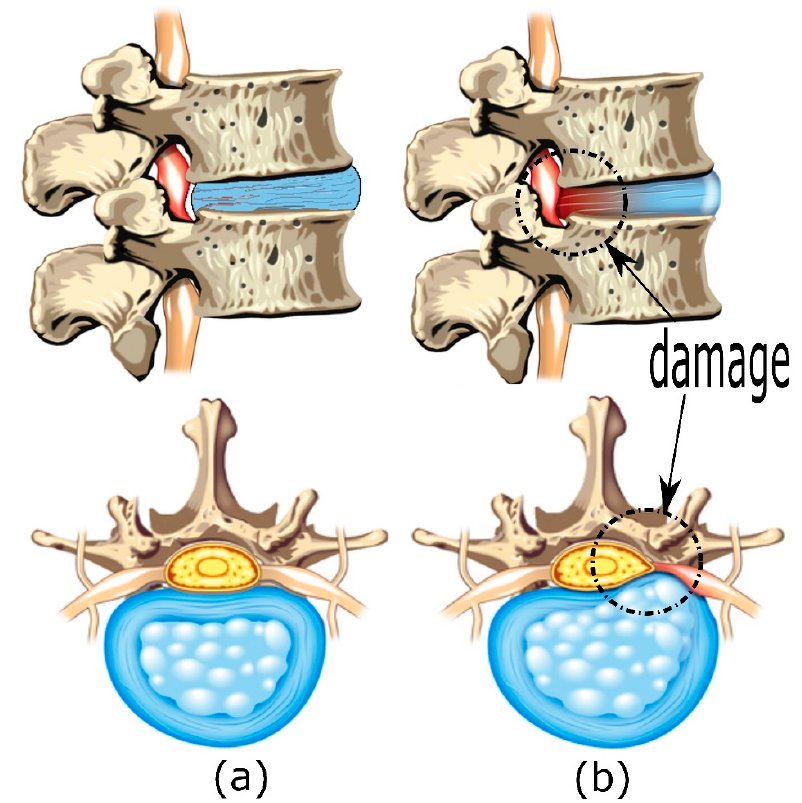
Figure 1. ( a ) Healthy Functional Spinal Unit ( b ) Detailed view of the nerve impingement and herniated intervertebral disc. intervertebral